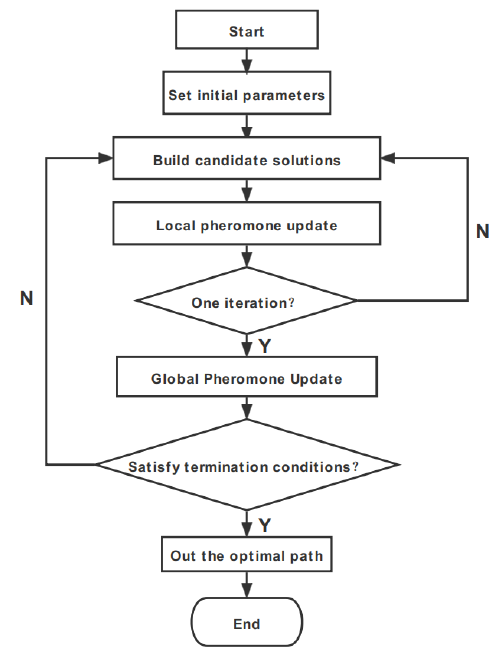
Figure 5. Flow chart of the ant colony algorithm.